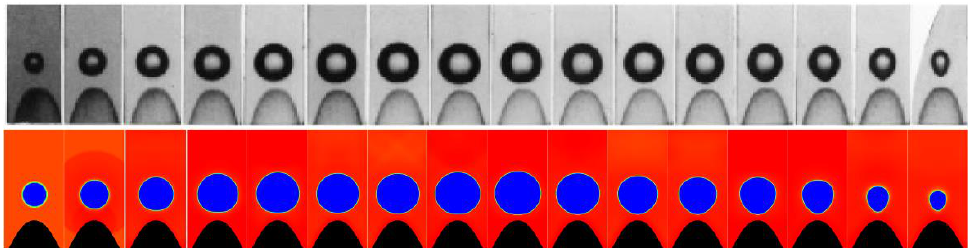
Figure 10. Experimental results [61] and simulation by DDF-LBM model, reproduced or adapted from adequate reference, with permission from publisher Cambridge University Press, 2021.